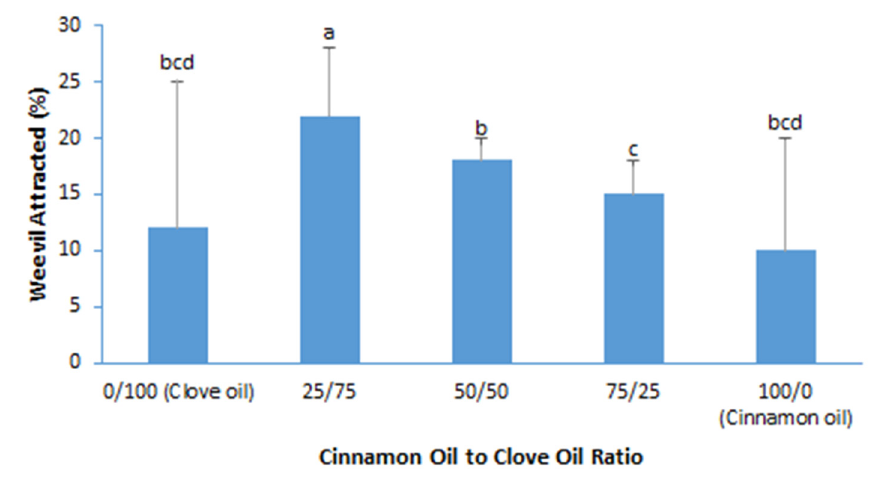
Figure 2. Percentage of maize weevil attracted to the mixtures of 10% cinnamon oil and clove oil. Data bars with different labels are significantly different at 5% significance level.